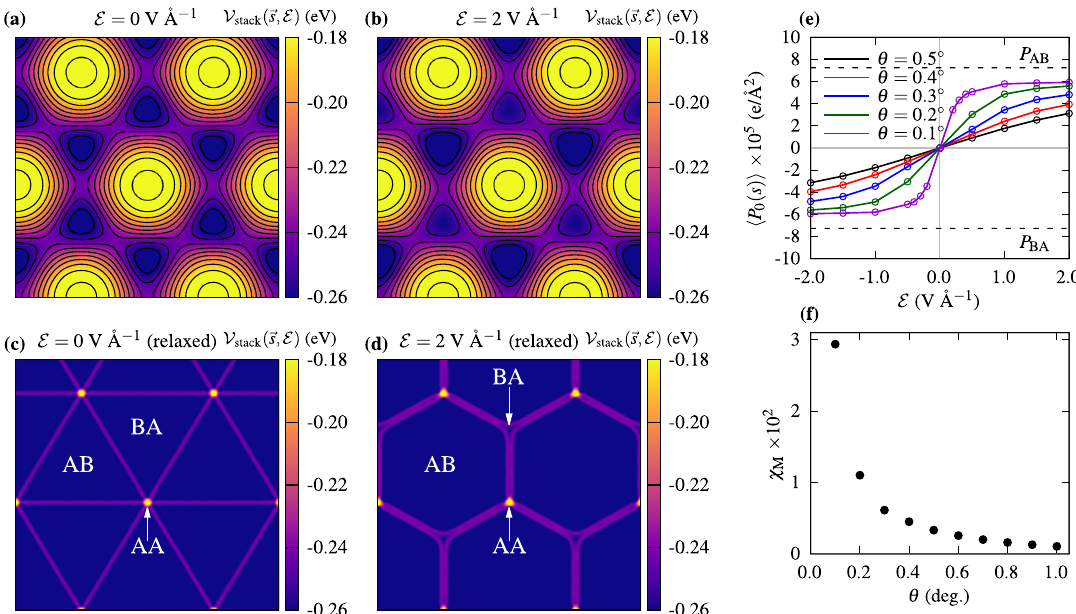
Fig. 4 Electrically tunable lattice relaxation and resulting polarization for 3R-stacked MoS 2 . a – d Lattice relaxation in con fi guration space for 3R MoS 2 , including the linear electrostatic term. The top panels show the stacking energy before lattice relaxation at electric fi eld strengths of ( a ): 0 V Å − 1 and ( b ): 2 V Å − 1 . c , d show the corresponding stacking energies after lattice relaxation at a twist angle of θ = 0. 1 ∘ . The AA regions (yellow) shrink and the AB/BA regions (purple) expand. When an electric fi eld is applied, the AB and BA regions relax unevenly, one increasing in area and the other decreasing. e Average polarization as a function of electric fi eld for several twist angles. f Susceptibility of the moiré superlattice χ M as a function of twist angle, obtained from the slopes from ( e ) about E ¼ 0